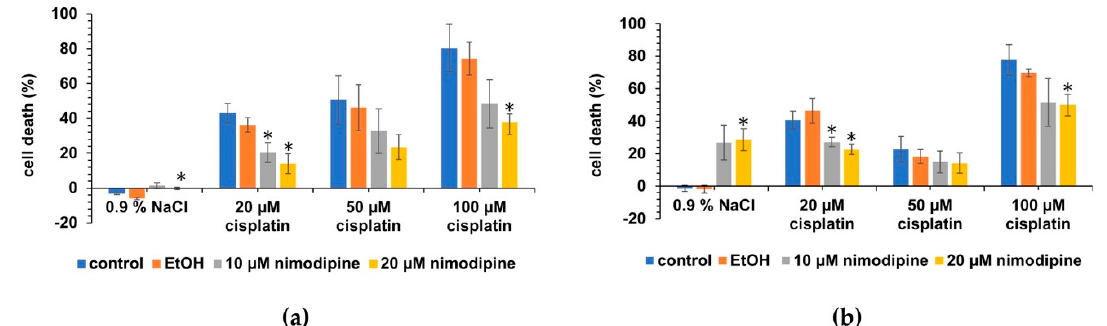
pre-treated UB/OC − 2 cells showed lower cytotoxicity under stress induced by 20 µ M, 50 µ M, and 100 µ M cisplatin (Figure 3b) than the untreated cells.